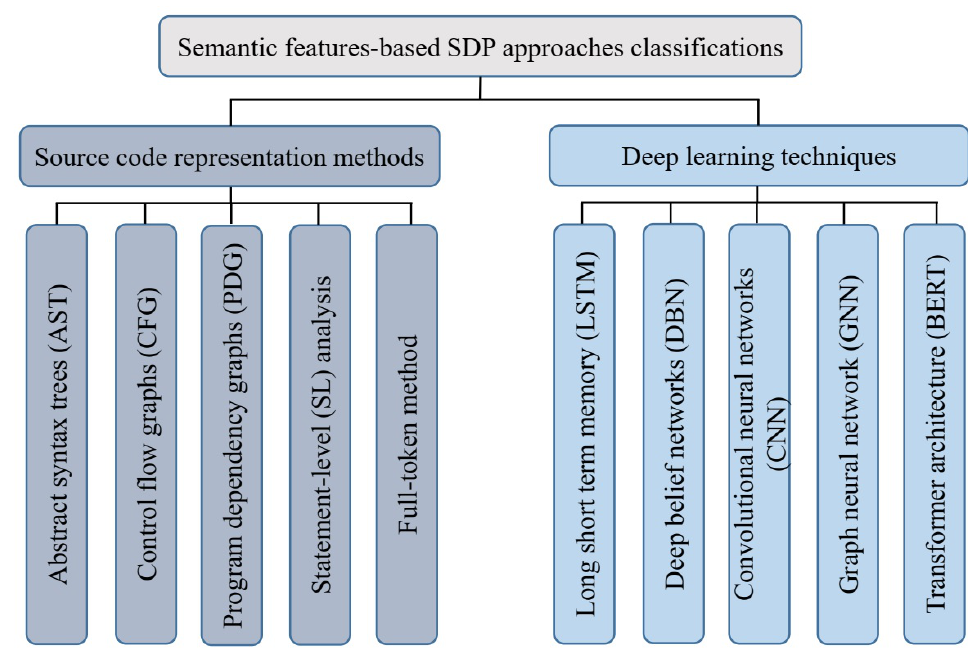
Figure 1. Semantic features-based SDP approaches